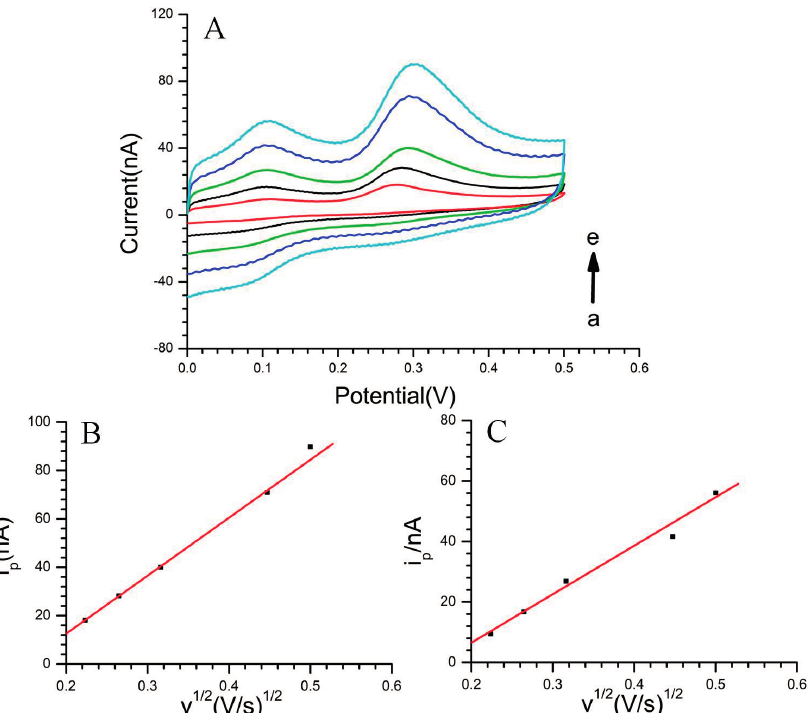
Figure 3. ( A ) CV of CS-MWCNT hybrid film-modified MEA in pH 7.4 phosphate buffer with 50 μ M DA and 100 μ M 5-HT. Scan rate (a–e): 50 mV·s − 1 , 70 mV·s − 1 , 100 mV·s − 1 , 200 mV·s − 1 , 250 mV·s − 1 ; ( B ) Linear relationship between the oxidation peak current of